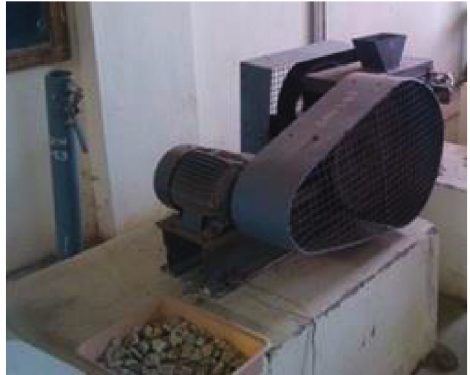
Figure 3: Jaw crusher for crushing tiles.